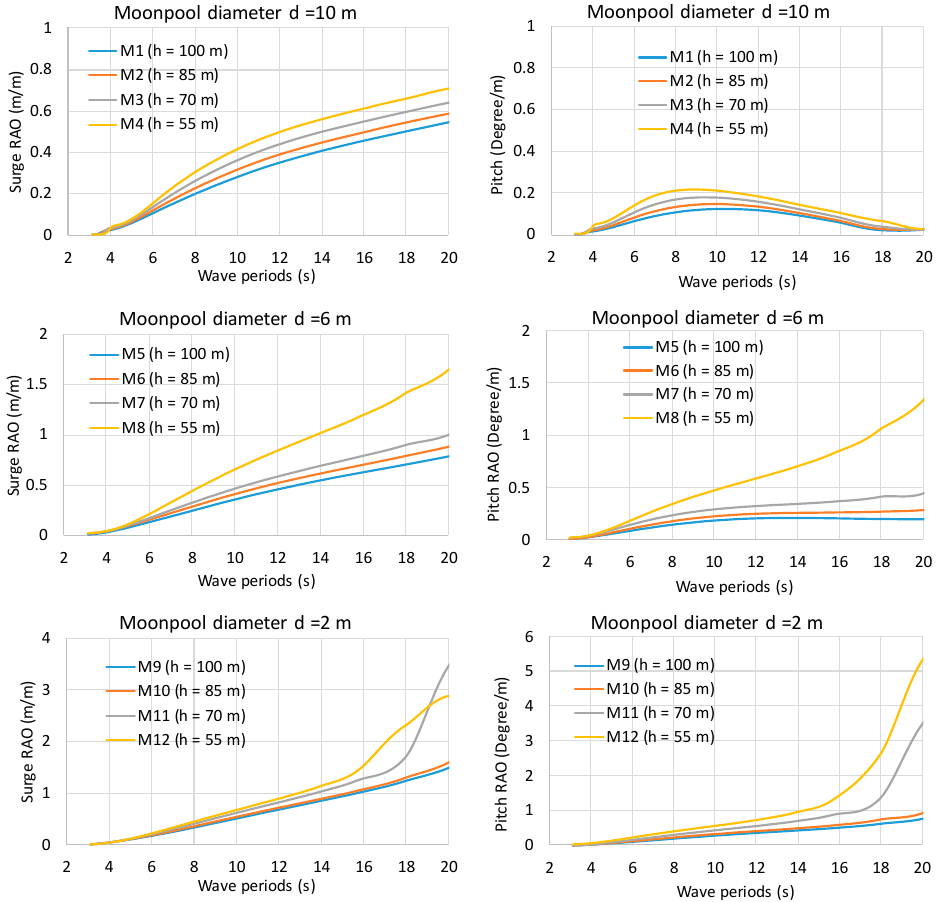
Figure 9. Comparisons of surge and pitch RAOs for difference moonpool diameters.